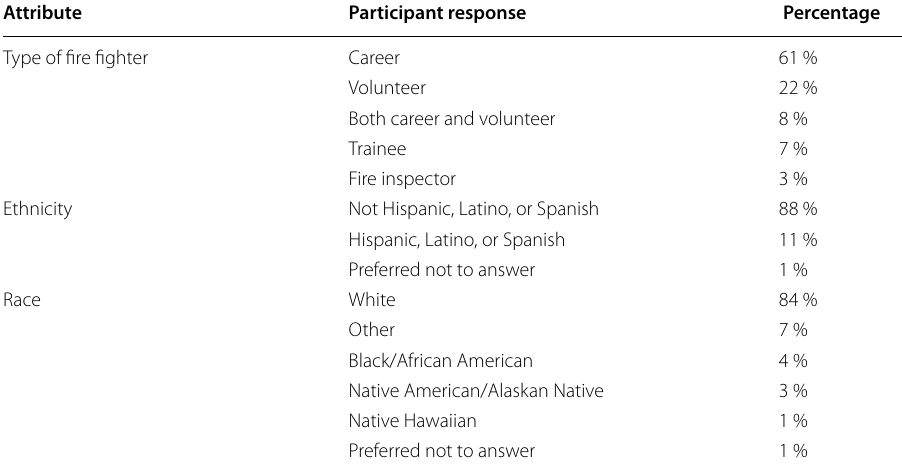
Total participants 74. 100% of the participants responded to all of the survey demographic questions =